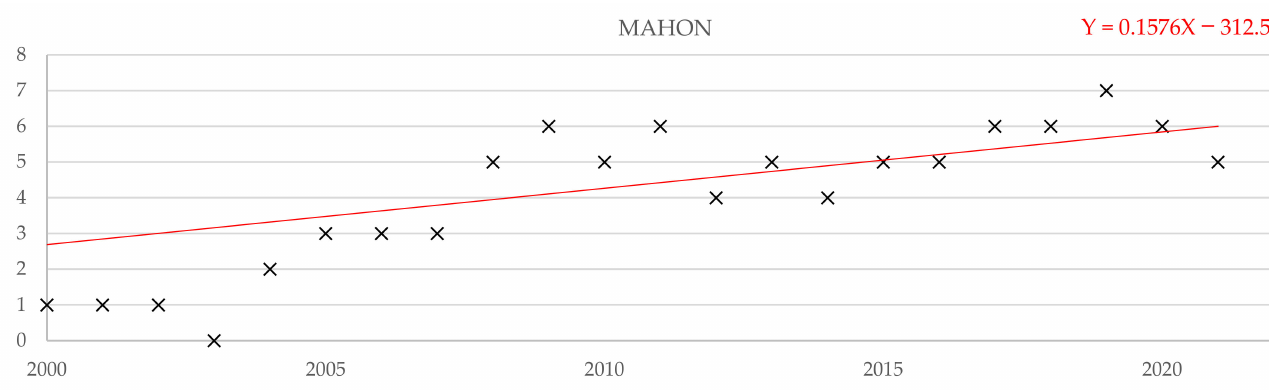
Figure 23. Number of times Hs has exceeded the threshold in Valencia.